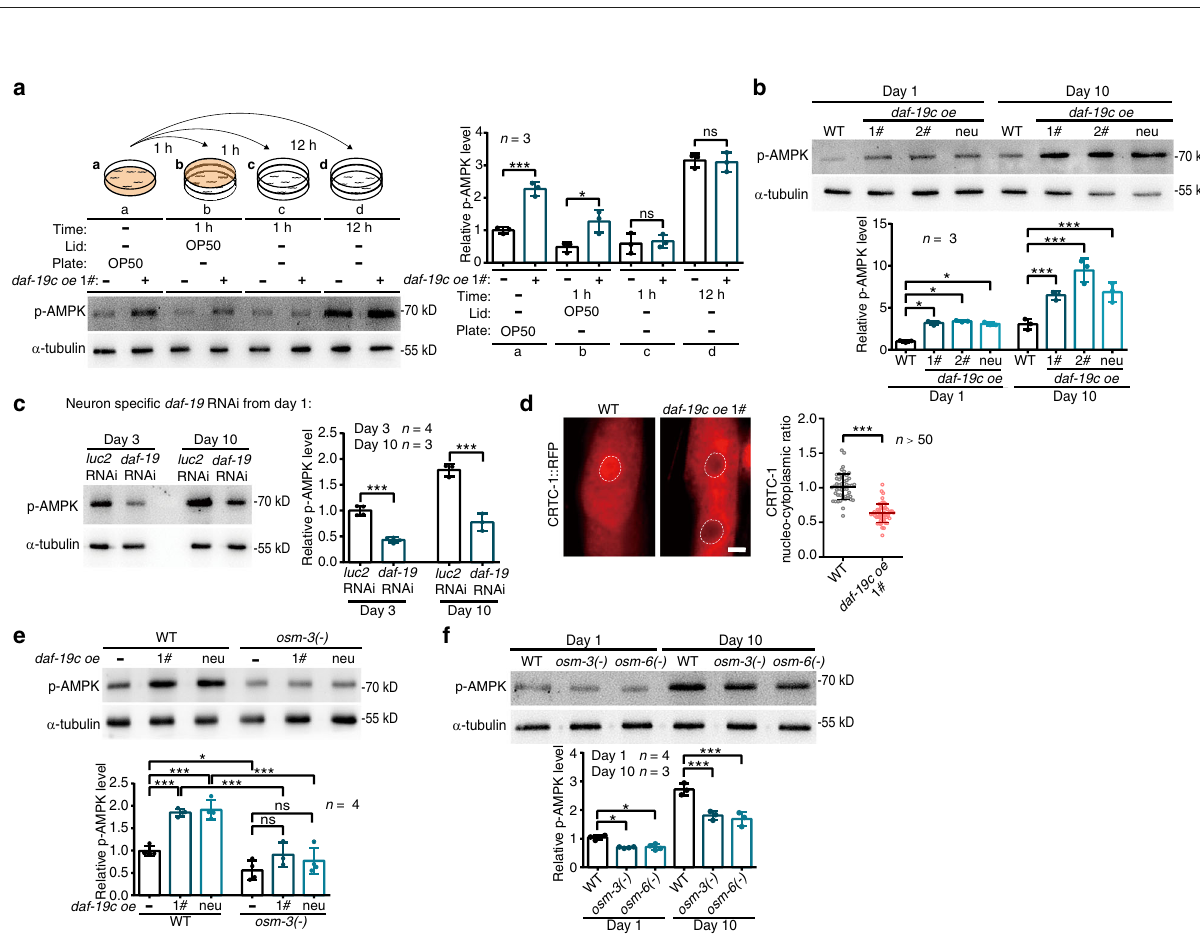
Fig. 4 The sensory cilia induce AMPK activity across tissues. a The phosphorylation levels of AMPK (p-AMPK) in young WT worms subjected to indicated treatments. The bacteria of OP50 (orange) is the food of C. elegans . Note that daf-19 upregulates p-AMPK only when worms are fed (OP50 in the plate, a ) or smell the food (OP50 on the lid, b ). n = 3 biological independent experiments. Exact p value are included in Source Data fi le. b Overexpressing daf-19c by its native promoter (1# and 2#) or a neuron-speci fi c promoter (neu) increases p-AMPK levels in both young and aged worms. n = 3 biological independent experiments. Exact p value are included in Source Data fi le. c Downregulating daf-19 in neurons from adulthood reduces p-AMPK levels in both young and aged worms. n = 3 biological independent experiments. Exact p value are included in Source Data fi le. d Overexpressing daf-19c reduces the nuclear localisation of CRTC-1::RFP in the intestinal cells. Dotted lines denote the nucleus of intestinal cells. Scale bar: 10 μ m. n = 51 and 52 animals, respectively. p < 0.0001. e Disrupting cilia by mutating osm-3 suppresses the increase of p-AMPK in the worms overexpressing daf-19c at day 1 of adulthood by its native promoter (1#) or a neuron-speci fi c promoter (neu). n = 3 biological independent experiments. Exact p value are included in Source Data fi le. f p-AMPK levels decrease in worm mutants with defected cilia ( osm-3(-) , osm-6(-) ). n = 3 biological independent experiments. Exact p value are included in Source Data fi le. α -tubulin serves as loading controls in western blot assays. Data are presented as mean ± SD. Unpaired t -test (two-tailed) in d , and one-way ANOVA in the rest. * p < 0.05, *** p < 0.001, ns non-signi fi cant. Source data with exact p values are provided as a Source Data fi